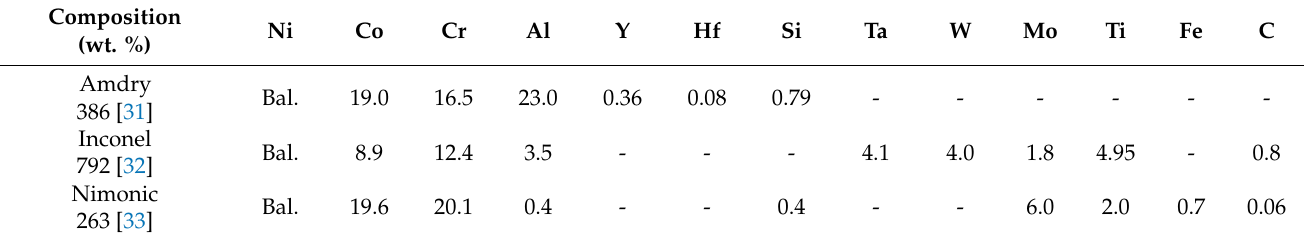
Table 1. Composition of feedstock powder and substrates.